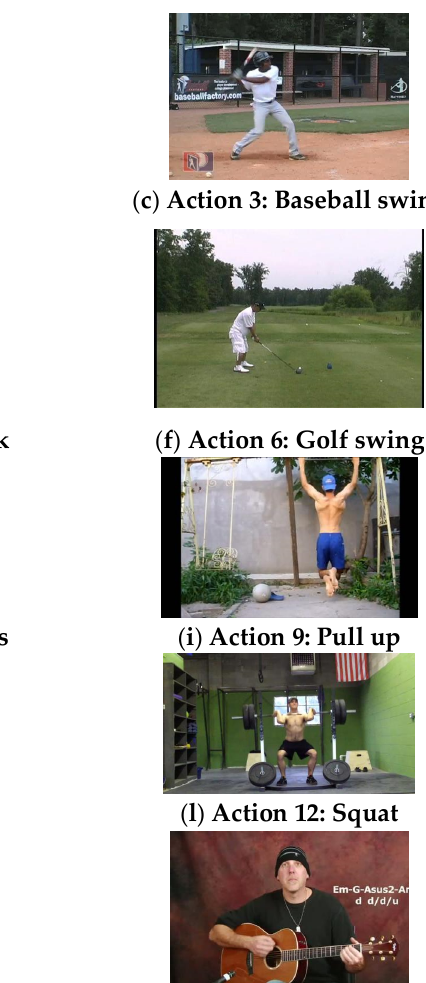
Figure 1. Sample images from the COCO dataset.